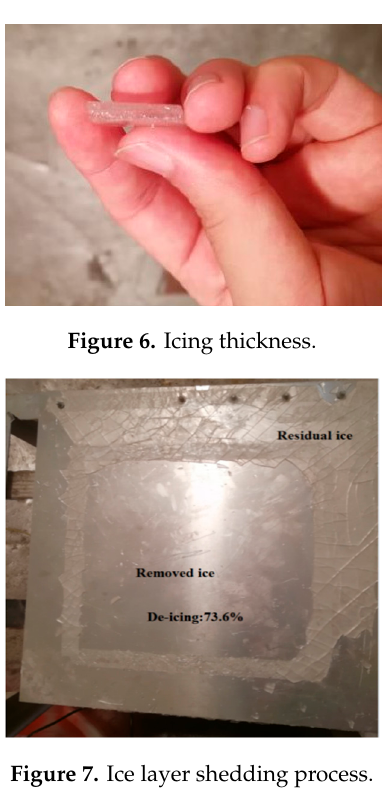
Figure 7. Ice layer shedding process.